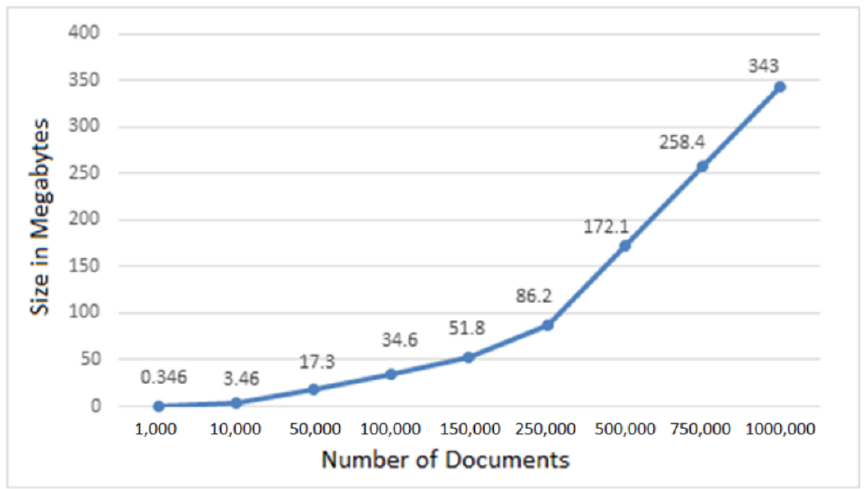
Figure 10. Number of documents versus data-size.